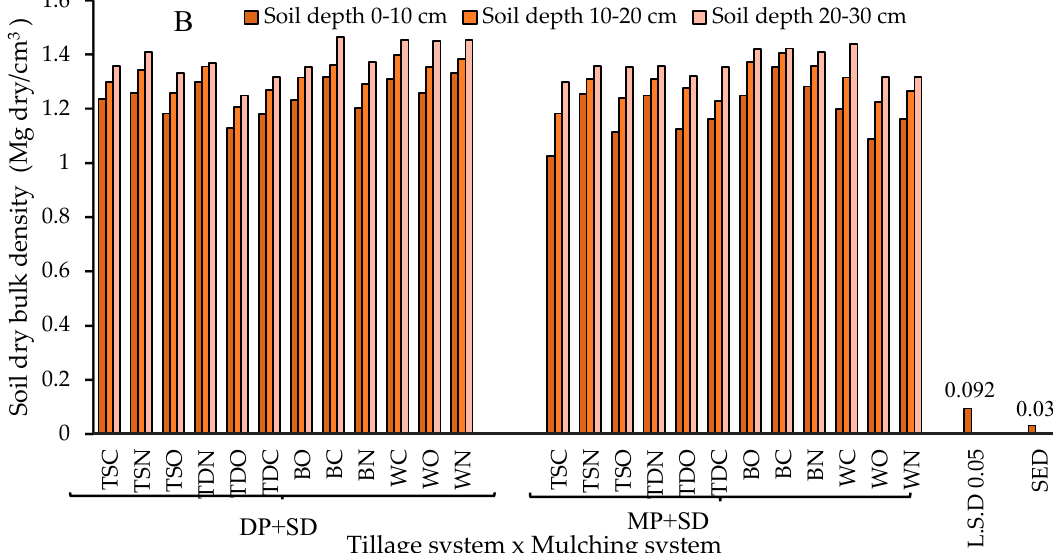
Figure 5. Interaction between the tillage system and mulching system, with three soil depths in soil wet ( A ) and dry bulk density ( B ), using the digital electromechanical system (DES). MP + SD, mouldboard ploughing and spring disk harrowing; DP + SD, disc ploughing (DP) and SD harrowing; TSC, transparent plastic (single sheet) and chemical fertilizer; TSW + , transparent plastic (single sheet) without fertilizer; TSO, transparent plastic (single sheet) and organic fertilizer; TDW, transparent plastic (double sheet) without fertilizer; TDO, transparent plastic (double sheet) and organic fertilizer; TDC, transparent plastic (double sheet) and chemical fertilizer; BO, black plastic and organic fertilizer; BW, black plastic without fertilizer; BC, black plastic and chemical fertilizer; WC, without mulch and chemical fertilizer; WO, without mulch and organic fertilizer; and WW, without mulch and fertilizer.